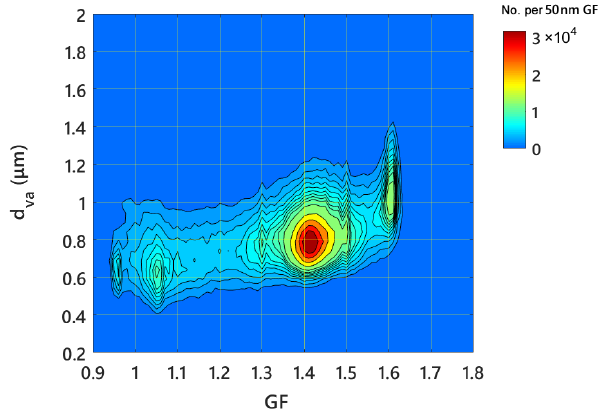
Figure 7. The distribution of ATOFMS particles as a bivariate func- tion of estimated GF and aerodynamic